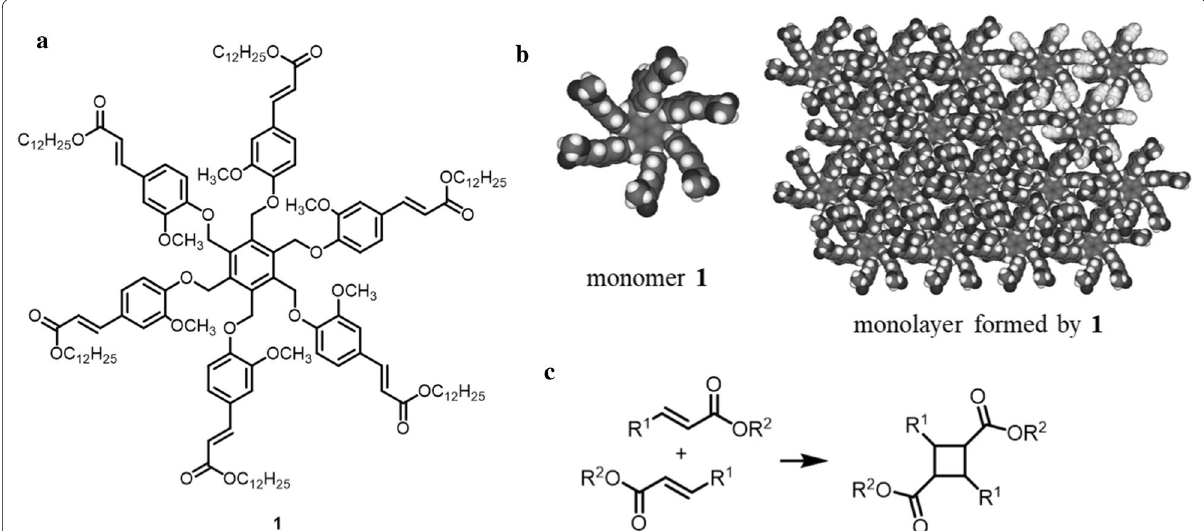
Fig. 2 Chemical structure and molecular models a Chemical structure of monomer 1, b molecular models of 1 (left) and monolayer formed by 1 (right), and c chemical reaction of photocycloaddition of cinnamate derivative. In ( b ), C 12 alkyl chains and some of the cinnamate units at an upper right part of the model of the monolayer are omitted for clarity